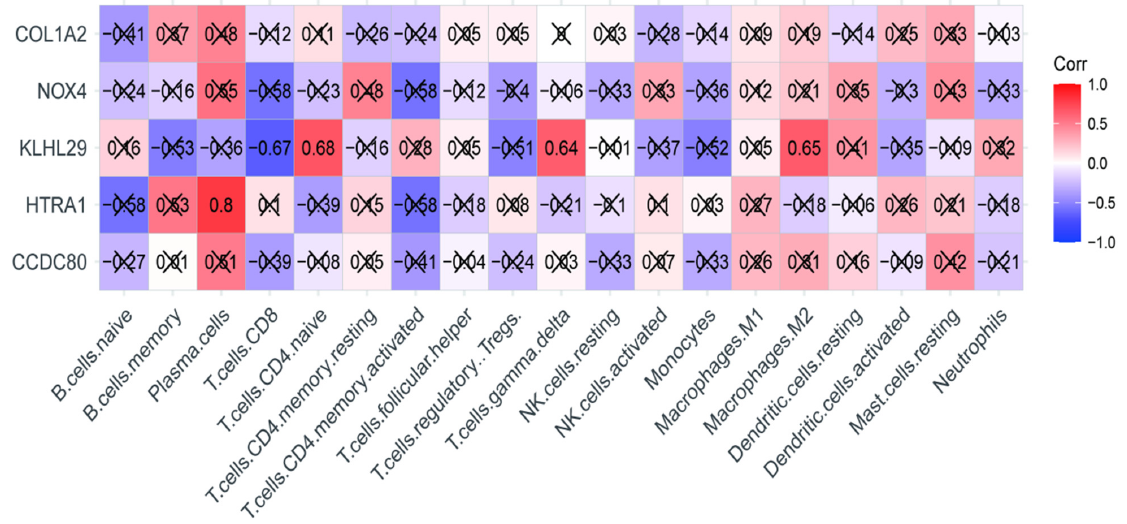
Figure 6. Correlation analysis between five key genes and immune cells. Purple squares represent negative correlation, and red squares represent positive correlation. The correlation coefficient showing in the squares is between − 1 and +1, and the larger the absolute value, the stronger the association. × p > 0.05.